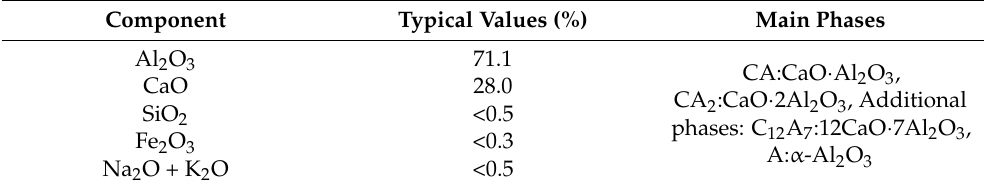
Table 1. Composition and properties of the CAC used. Component Typical Values (%) Main